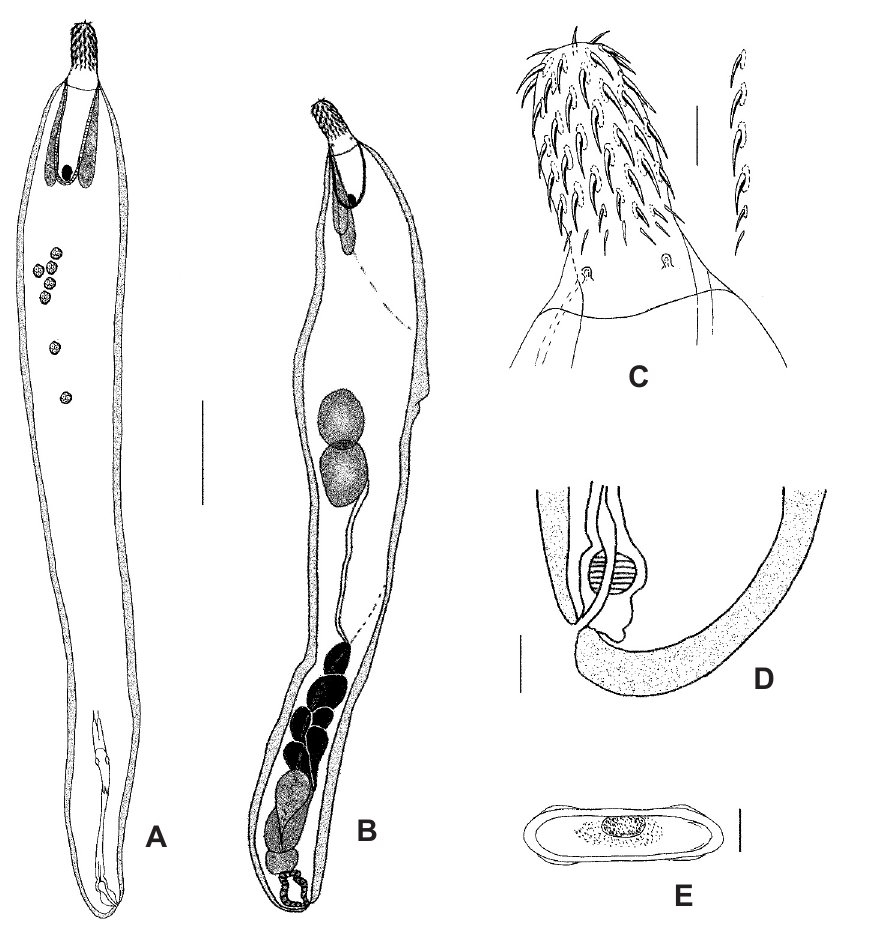
Fig. 4. – Solearhynchus soleae (Porta, 1905) de Buron & Maillard, 1985. From Pegusa impar , France. Type specimens (samples in alcohol),